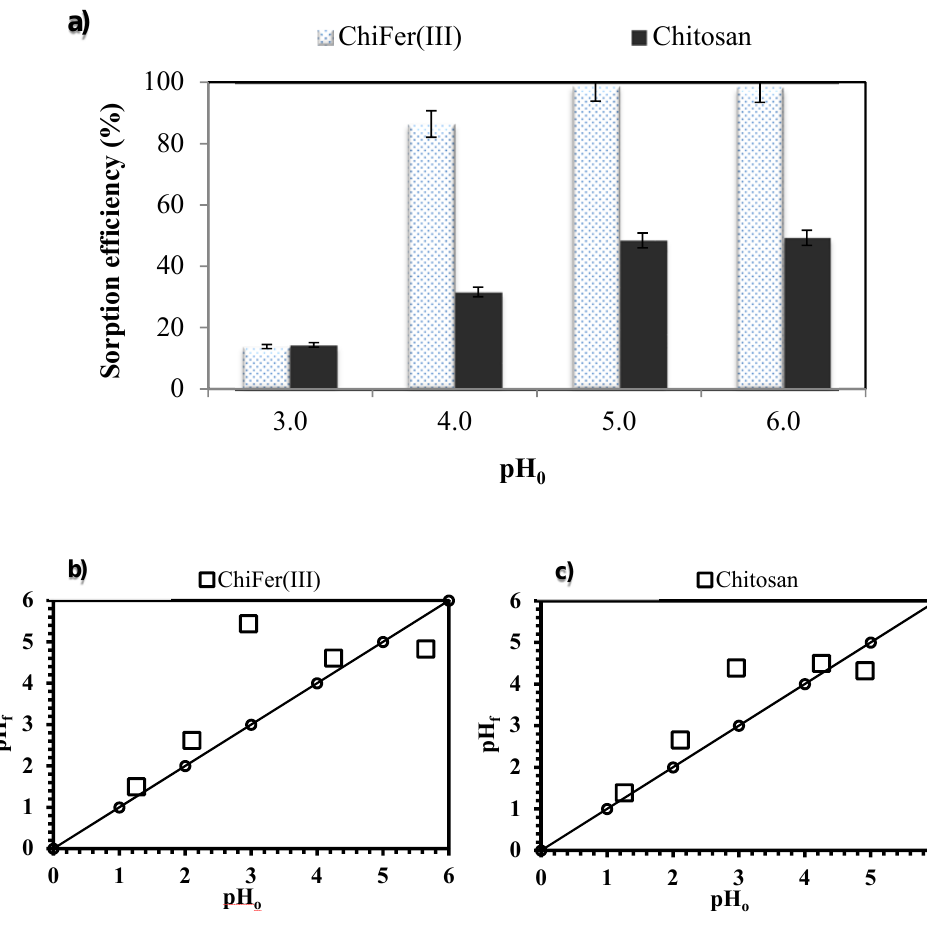
Figure 4. Influence of pH on neodymium removal. ( a ) Sorption efficiency. ( b ) Variation in pH using ChiFer(III) as sorbent. ( c ) Variation in pH using chitosan as sorbent. (T: 20 °C; sorbent dosage, SD: 1 g L − 1 ; agitation speed: 150 rpm; contact time: 72 h; C 0 :9.4 mg L − 1 ).